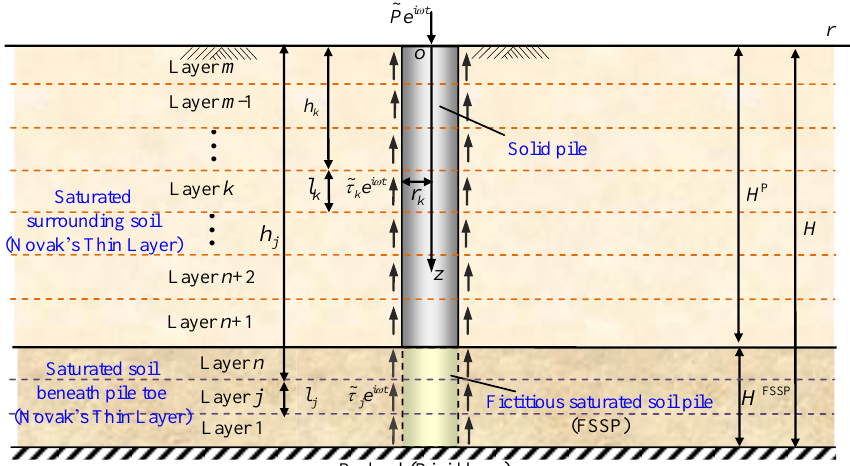
Figure 1. Coupled vibration of a pile – soil system.